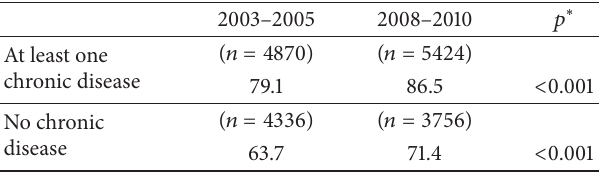
Table 1: Percentage of respondents having a regular source of PHC